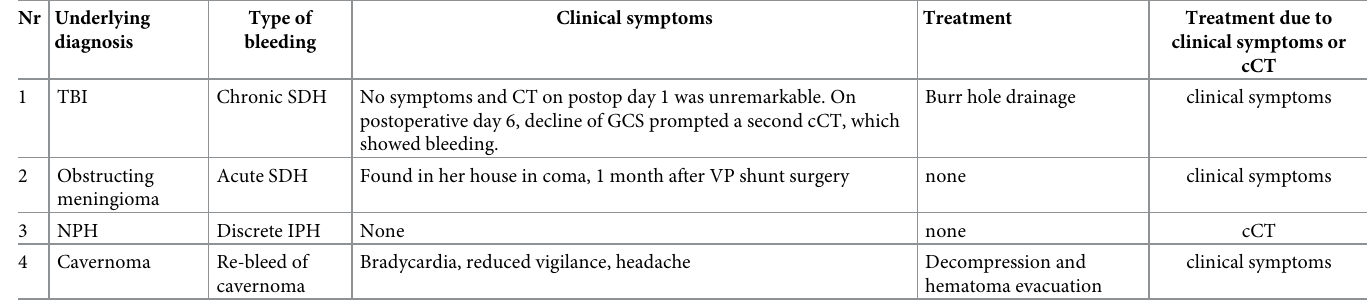
Table 3. Data of patients with postoperative